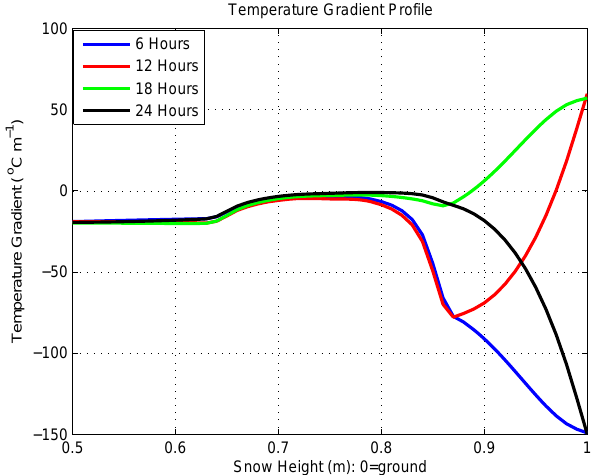
Figure 14. Snowpack temperature gradients over a 24h period with time dependent surface boundary conditions given by Eq.